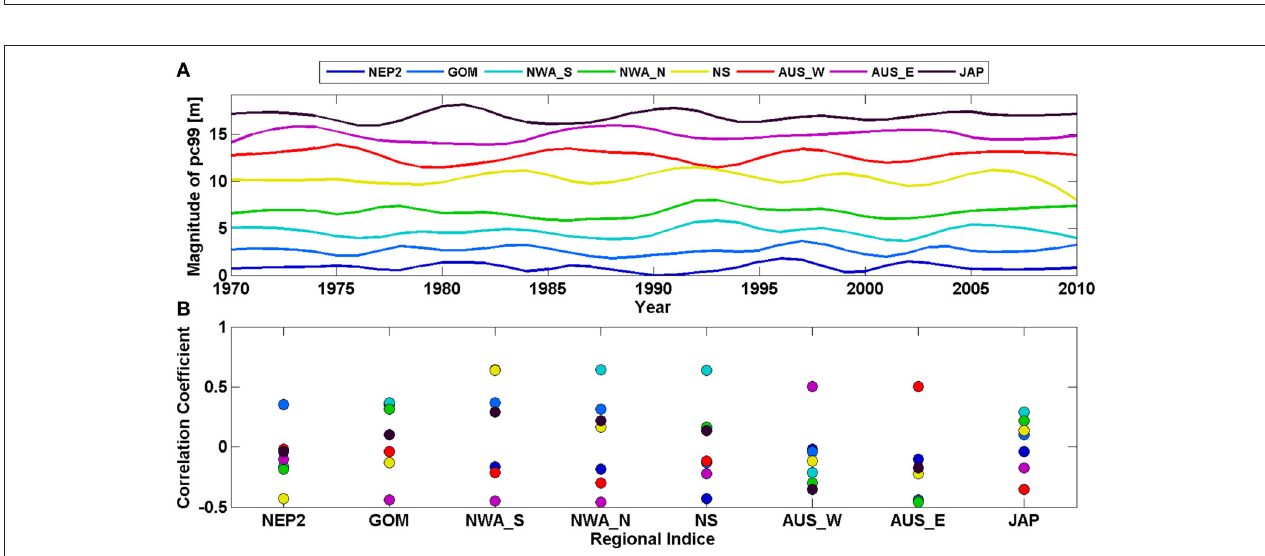
FIGURE 11 | (A) Stacked time series of filtered regional skew surge indices, with arbitrary offset applied, (B) Correlation of each filtered regional skew surge index against the others.